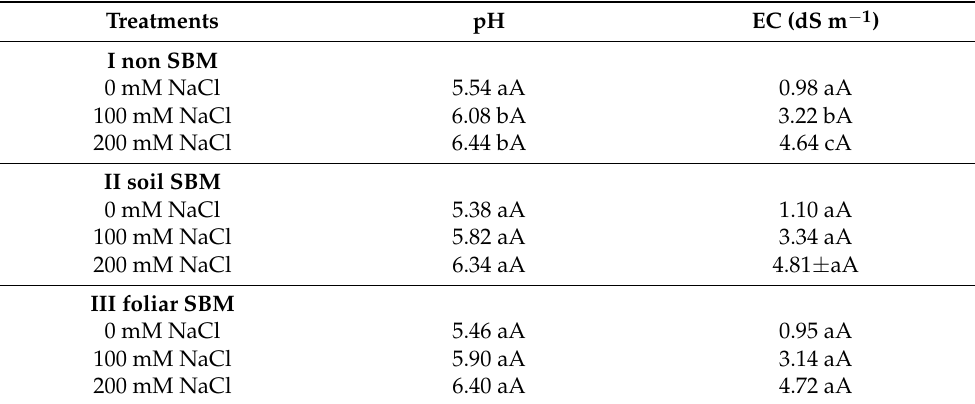
Table 1. Effect of sodium chloride and molasses on soil pH and soil EC after 5 weeks of plants